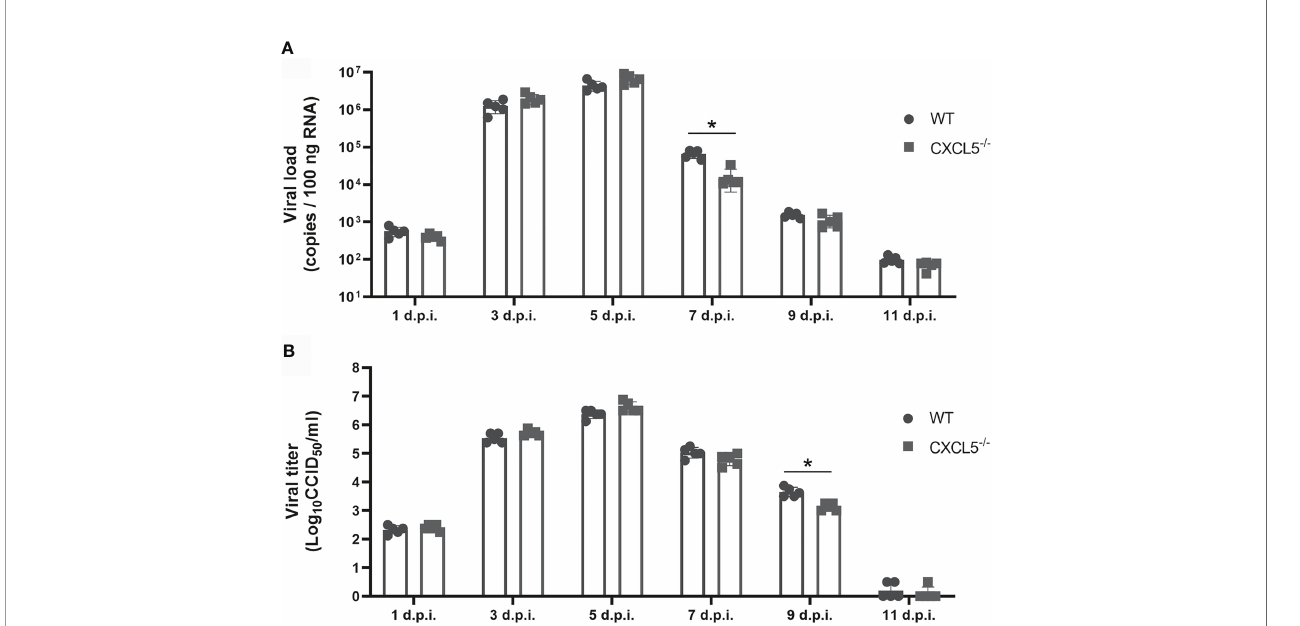
FIGURE 3 | Viral loads and viral titers after in fl uenza infection. Lungs were harvested from H1N1-infected WT and CXCL5 -/- mice, and homogenates were prepared for analysis of viral titers and loads. (A) Viral loads were determined based on the number of in fl uenza M gene RNA copies detected by RT-qPCR at different d.p.i. (B) The titers of infectious viruses were determined using a standard CCID 50 assay at different d.p.i. The error bars represent the SDs of 5 samples. *P < 0.05 based on Student ’ s t